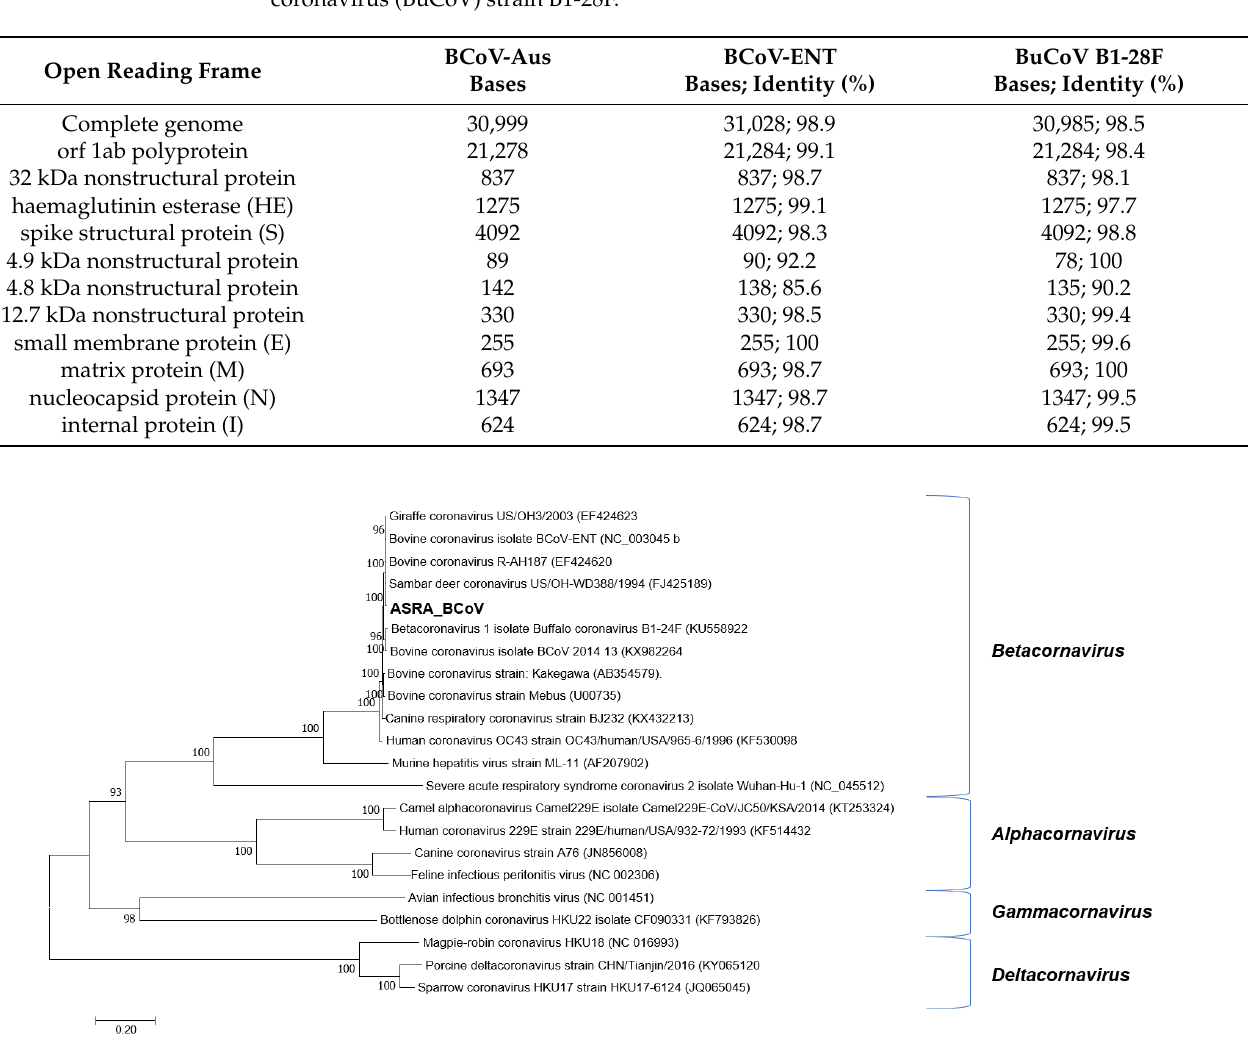
Figure 2. Phylogenetic tree of Coronaviridae based on the ORF1ab gene. The phylogenetic tree was constructed using the maximum likelihood method based on the general time reversible model. Bootstrapping of 500 replicates was performed. Phylogenetic analysis of the predicted nucleotide sequences determined in this study. In order to determine the best DNA model to use for phylogenetic analysis, model selection was performed, which analysed the maximum likelihood fits of 24 different nucleotide substitution models. The trees are drawn to scale, with the scale bar representing the number of nucleotide substitutions per site. Numbers at nodes represent percentage bootstrap support (values are indicated for each node >50%). The Australian sequences from this study are